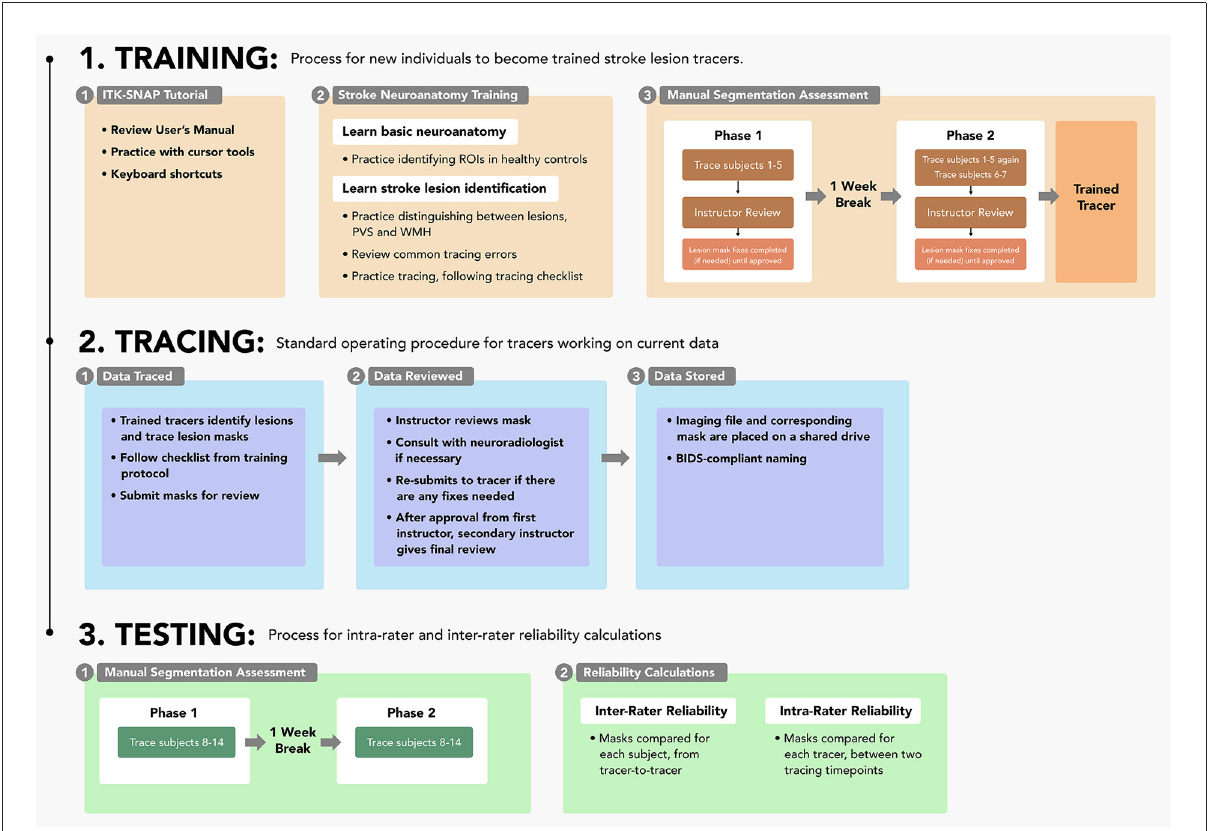
FIGURE1 Protocol sections: A flowchart outlining each of the three parts of the protocol (training, tracing, and testing) and their respective